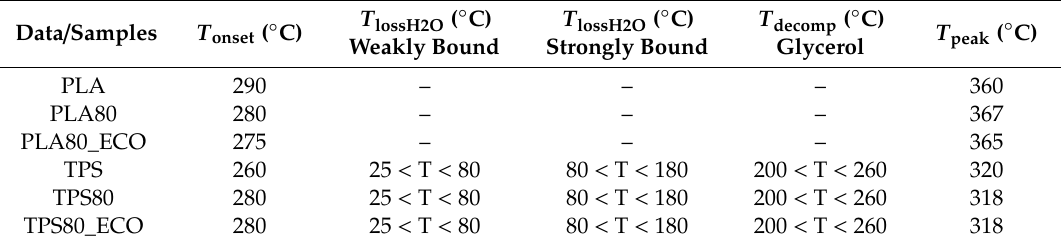
Table 1. Thermal parameters of PLA- and TPS-based blends from TGA